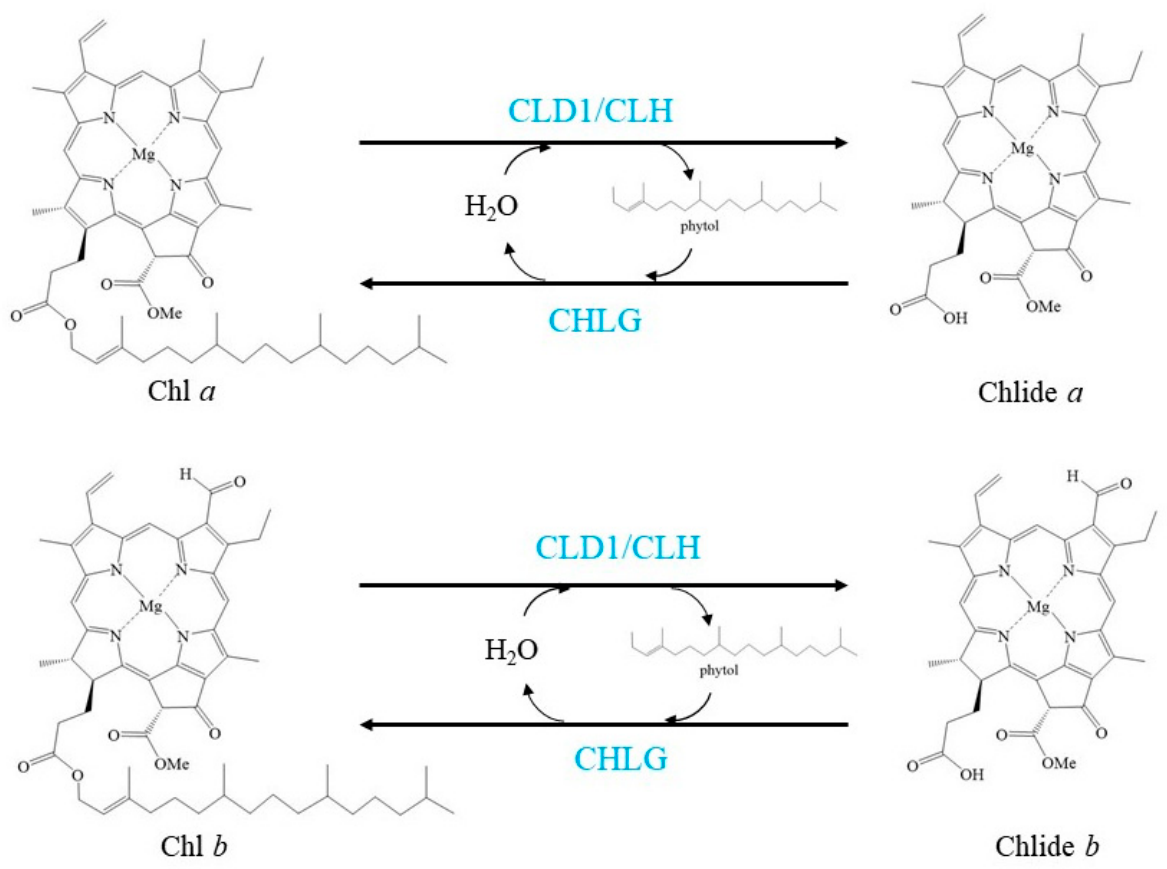
Figure 2. Schemes of the enzymatic reactions in Chl turnover. Blue characters indicate the